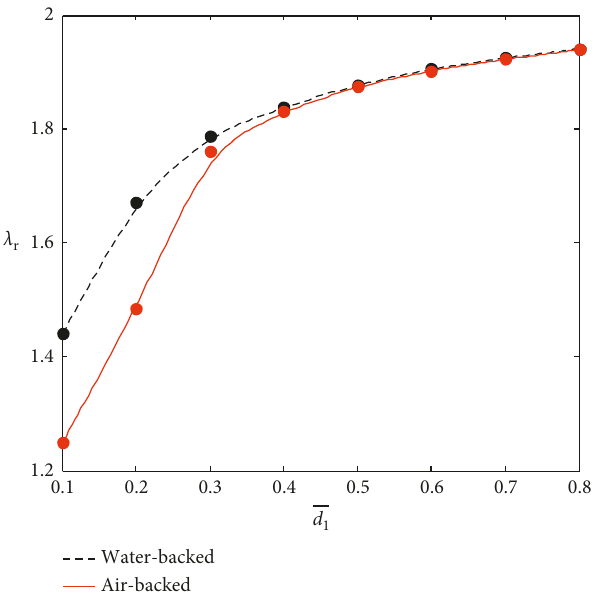
Figure 12: The reflection coefficients of peak pressure for different outer shell thicknesses.